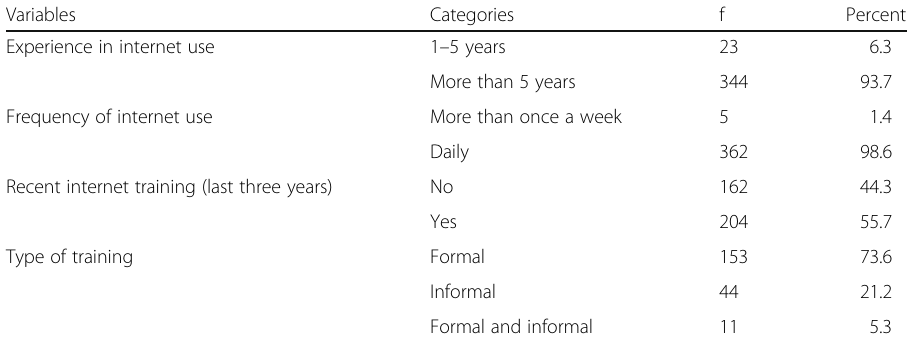
Table 1 Technological profile of participants